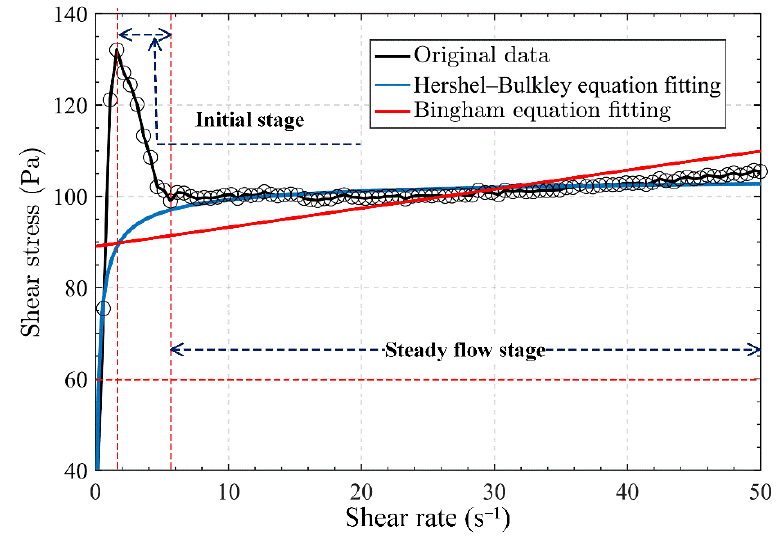
Figure 6. Fitting flow curve comparison.